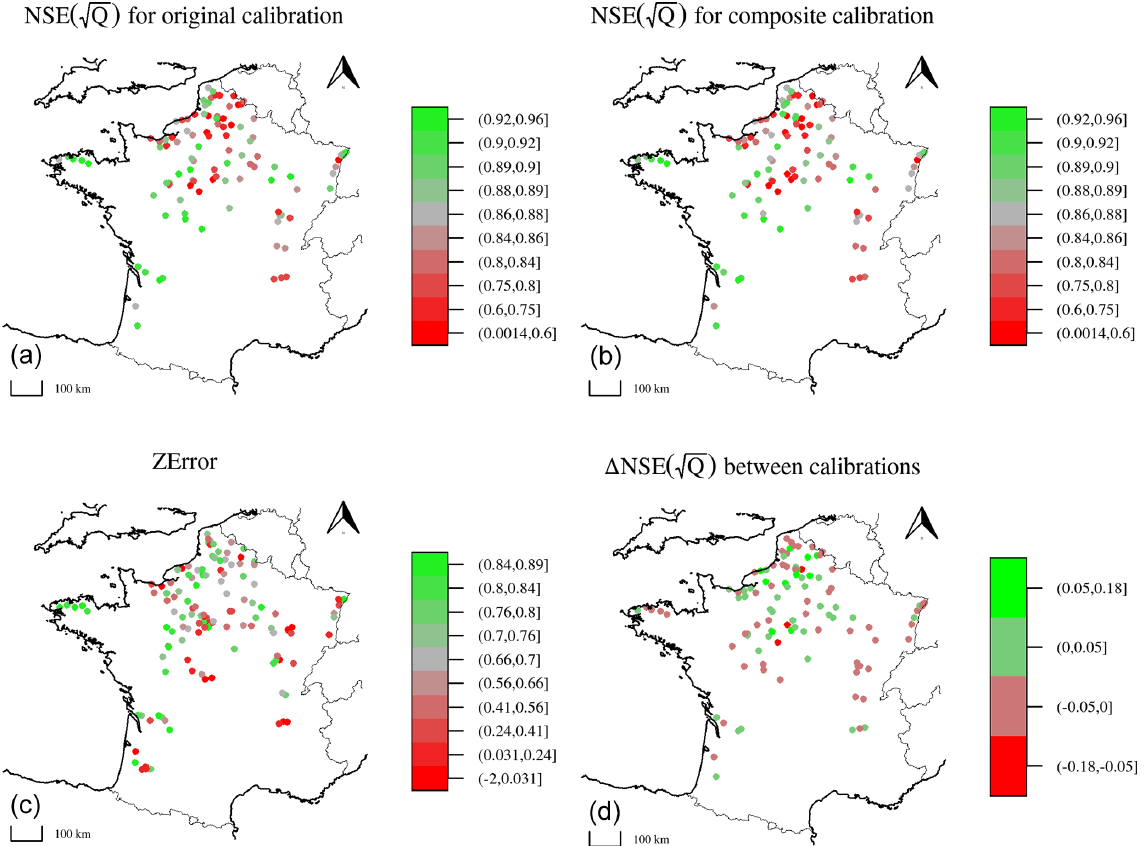
Figure 16. Maps of the results. From (a) to (d) : the value of the Nash–Sutcliffe efficiency at each gauge station, computed on the square root of the streamflow, for the original calibration, i.e. α = 0; the value of the Nash–Sutcliffe efficiency at each gauge station, computed on the square root of the streamflow, for the composite calibration with α = 0 . 16; the value of the Z Error criterion at each piezometer for α = 0 . 16; the difference between the NSEs obtained with the composite and the original calibration frameworks. For each point, the maximum value among the catchment/piezometer pairs was